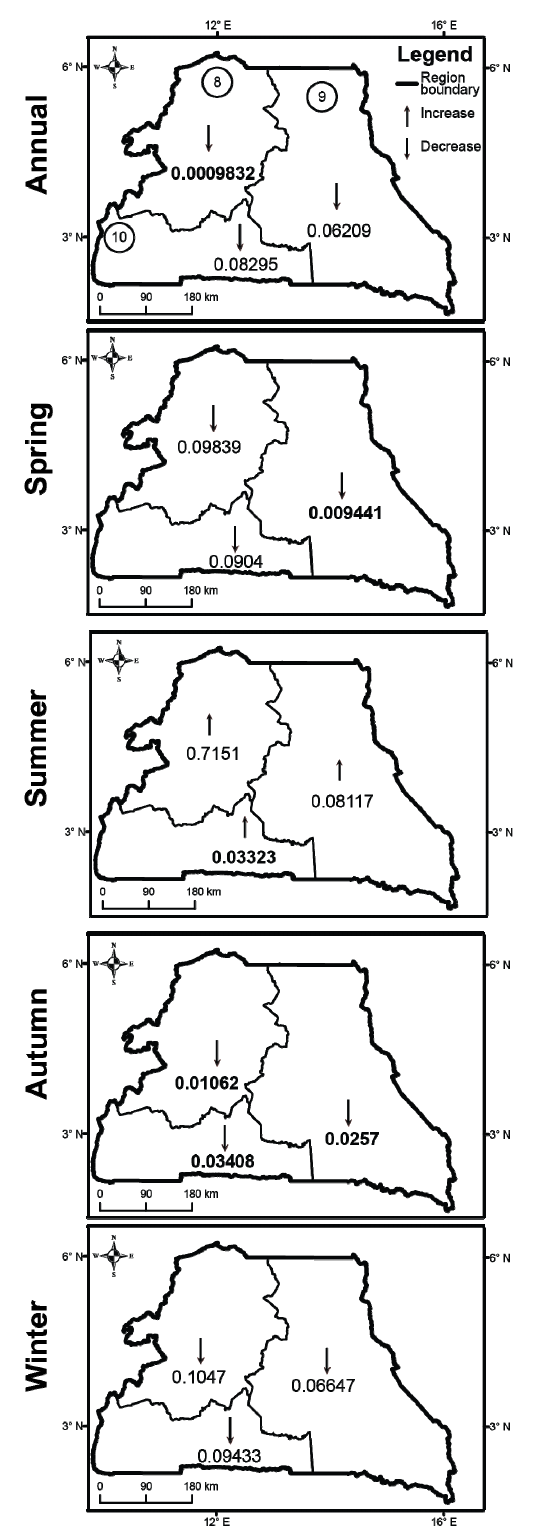
Figure 6. Results of annual and seasonal rainfall for the southern regions of the country (South (10), East (9), and Center (8)), using Mann–Kendall’s test. There is a significant trend in the series when the calculated p -values are below the significance level ( α = 0.05). Significant trends are indicated by values in bold.